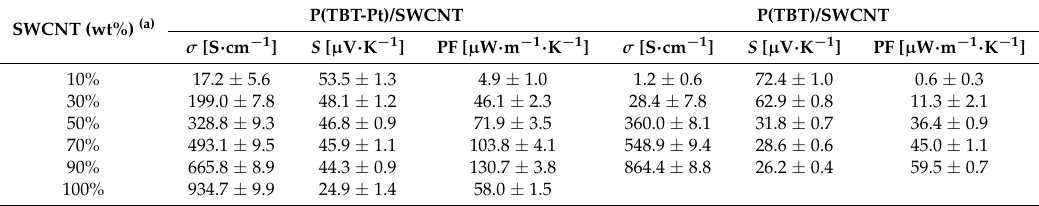
Table 1. Thermoelectric (TE) parameters of P(TBT-Pt) and P(TBT) hybrid films at room temperature. (a) Refer to the mass ratios of SWCNT. SWCNT (wt%) a)